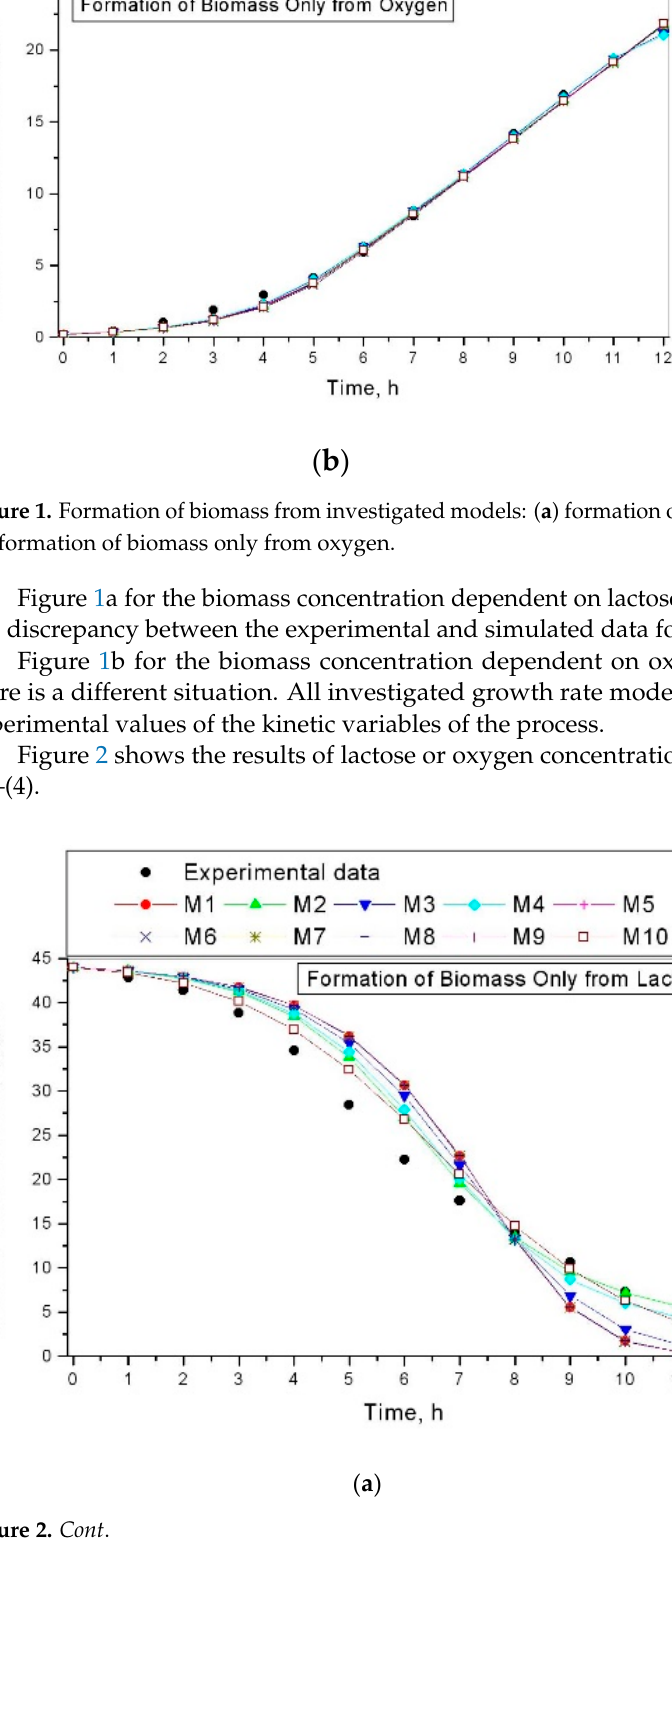
( b ) Figure 2. Lactose and oxygen concentration for investigated models: ( a ) lactose concentration for models (1)–(2); ( b ) oxygen concentration for models (3)–(4). Figure 2a, b shows a similar situation to the reasoning made for Figure 1a, b. The modeling of the lactose concentration model (1)–(2) shows a relatively lower correspond- ence between the experimental and simulated results compared to the results obtained by models (3)–(4), shown in Figure 2b. These results show that the influence of oxygen on the cell growth kinetics is more than that of lactose. The application of the ICDA method will show which models will drop out. 3.2. Application of ICDA Method In ICDA, the method is included in the criteria C 1 – C 8 . The objects (alternative) in the ICDA are the investigated growth rate models. The method is used for the selection of the growth rate for independent models (1)–(2) and (3)–(4). For selecting growth rate models,